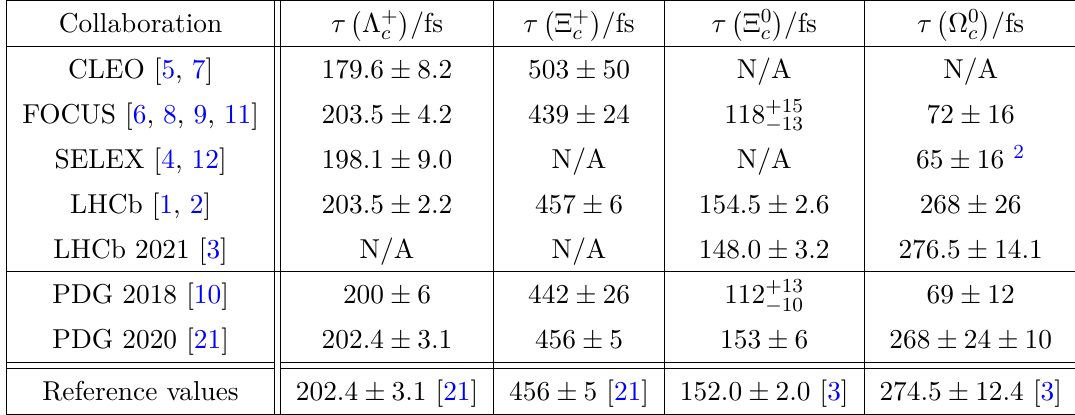
Table 2. Summary of lifetime measurements of singly charmed baryons. All results are expressed in femtoseconds. As in table 1, we combine statistical and systematic errors in quadrature. The PDG world-average (as of 2018 and 2020, showing the changes due to the LHCb results) is also included. Lifetime measurements that are not available (due to never being performed at the given experiment, or at least with no existing reference) are marked “N/A”. The most recent LHCb determination, of the Ω 0 and Ξ 0 lifetimes, is given in a separate row to highlight the two separate measurements. In c c the last row we list the most precise current results used as the reference values for the comparisons to our theoretical predictions, taken from PDG [21] for the Λ + and Ξ + , and from the LHCb averages c c given in [3] for the Ξ 0 and Ω 0 c c